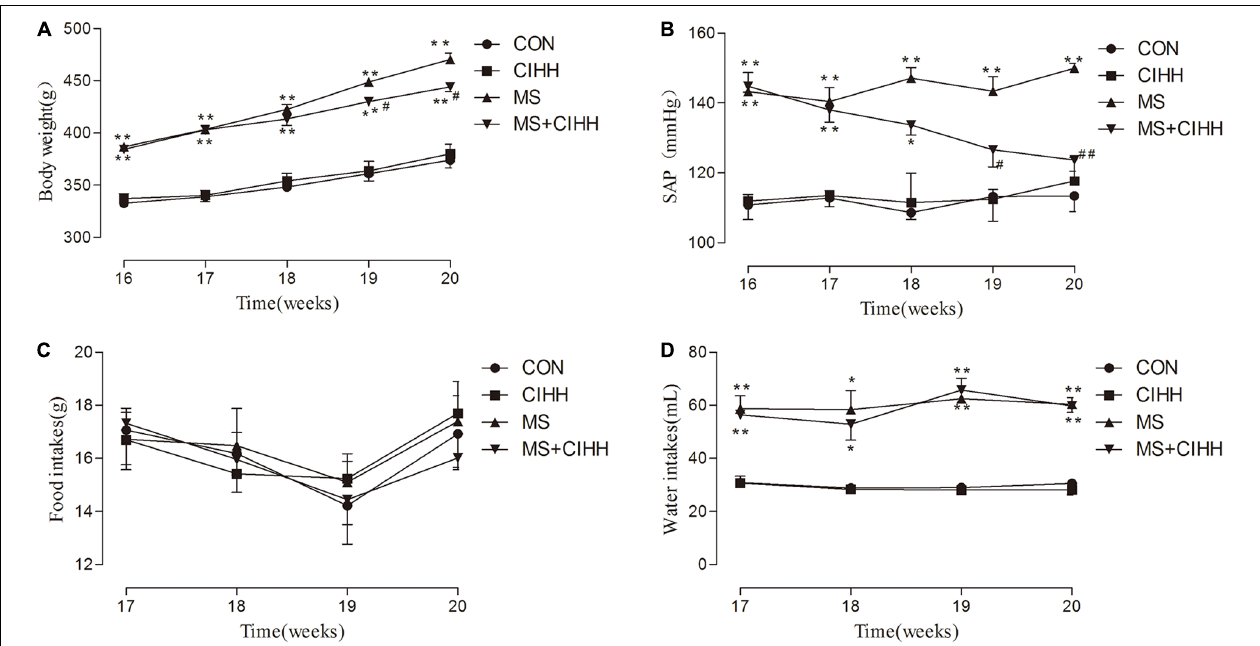
FIGURE 1 | The effect of CIHH on body weight, systolic arterial pressure (SAP), food and water intakes. (A) The effect of CIHH on body weight. (B) The effect of CIHH on SAP. (C) The effect of CIHH on food intakes. (D) The effect of CIHH on water intakes. CON: control group, CIHH: CIHH group, MS: metabolic syndrome group, MS + CIHH: MS + CIHH group. All data were expressed as mean ± SD; n = 5–6 for each group. * P < 0.05 ** P < 0.01 vs. CON, # P < 0.05 ## P < 0.01 vs. MS.